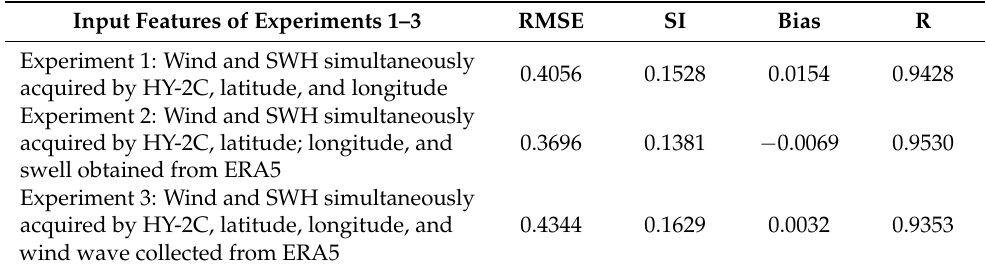
Table 1. Numerical results of the test set in the GRU model with different input